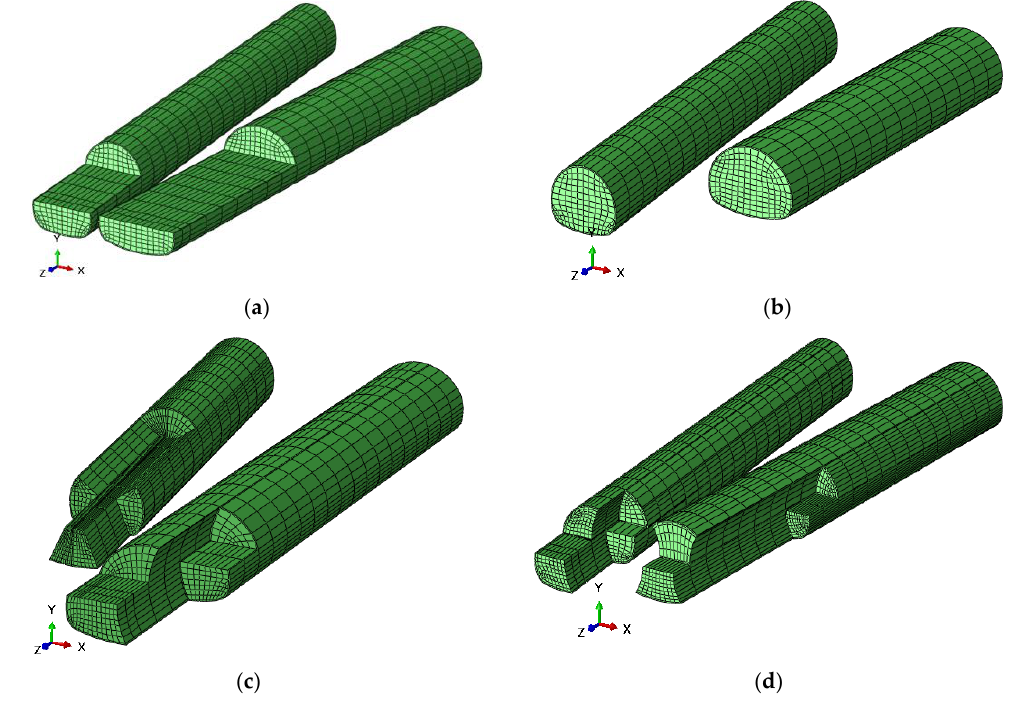
Figure 4. The layout of each excavation scheme: ( a ) Step method; ( b ) Full section method; ( c ) CD method; ( d ) Double wall heading method. method; ( d ) Double wall heading